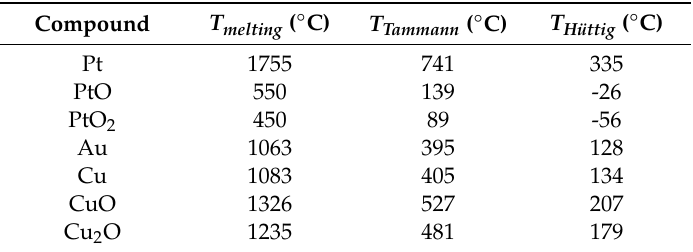
Figure 2. HR-TEM images of the prepared catalysts: ( a ) Pt–Au / Al, ( b ) Cu–Au / Al, ( c ) Pt–Au / Ce, ( d ) Cu–Au / Ce, ( e ) Pt–Au / Ce–Al, and ( f ) Cu–Au / Ce–Al. Table 2. Melting point, Tammann, and Hüttig temperatures (converted from kelvin) for dispersed metals and their oxide forms (modified from Moulijn et al.